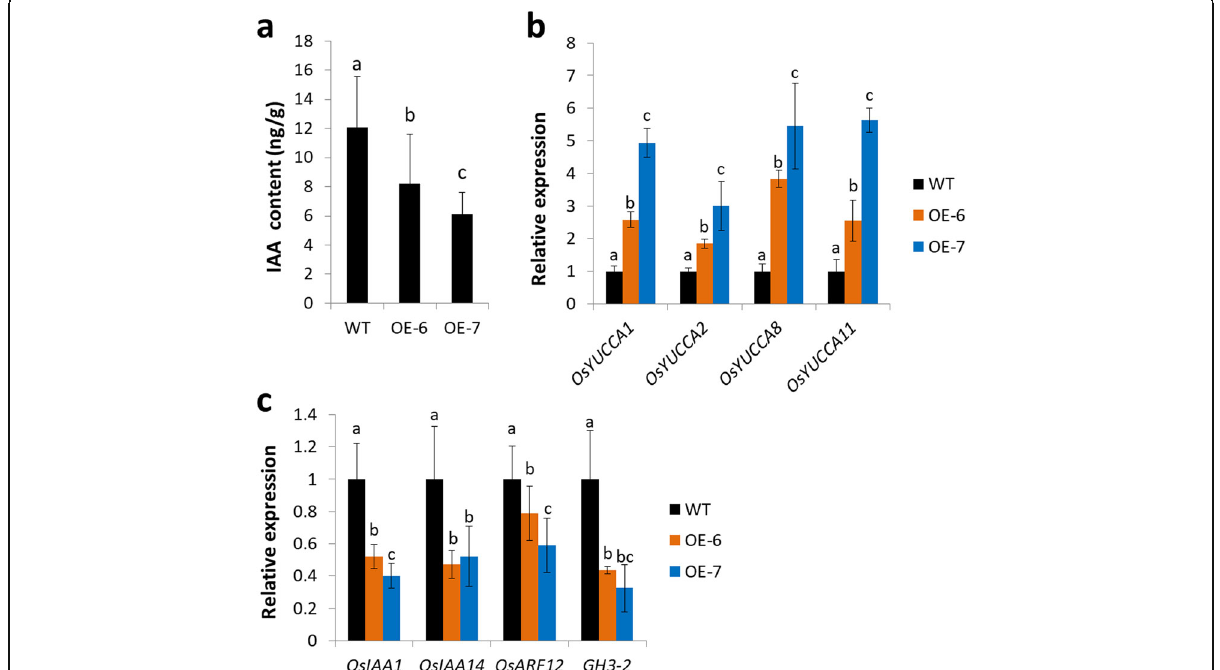
Fig. 7 Auxin content and expression of auxin related genes in OsIAGT1 overexpression rice plants. a IAA content in 7-day-old rice. b Expression of auxin synthesis genes in 7-day-old OsIAGT1 overexpression rice plants compared to WT. c Expression of auxin-responsive genes in 7-day-old OsIAGT1 overexpression rice plants compared to WT. Transcript levels were normalized relatively to the mRNA levels of OsActin1 . Values are means ±SD ( n ≥ 3). Different lower-case letters indicate significant difference based on the Duncan ’ s multiple range test ( p